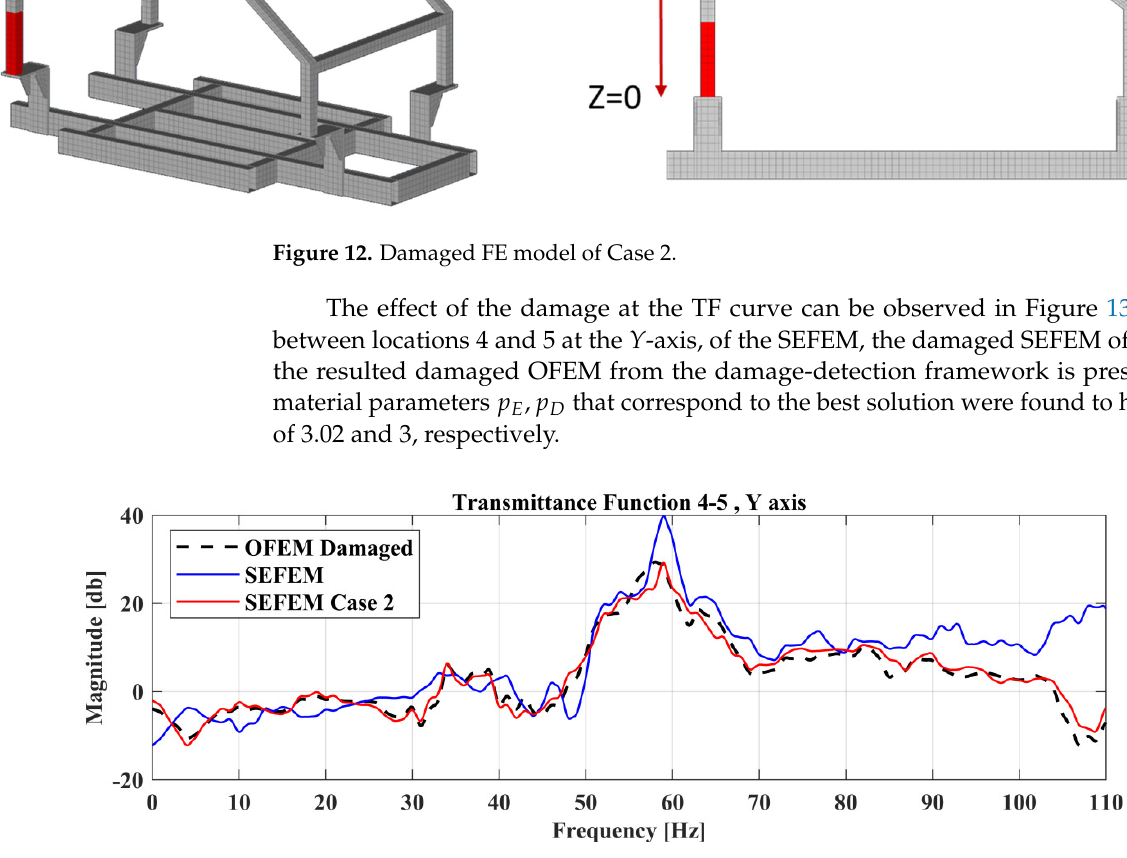
Figure 13. Comparison of TFs between the SEFEM, damaged OFEM, and damaged SEFEM of Case 2.